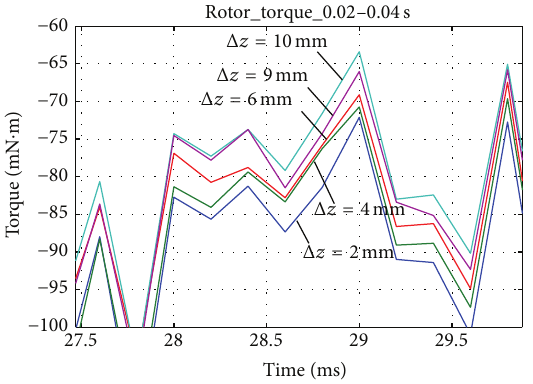
Figure 13: Enlarged view of the electromagnetic torque.